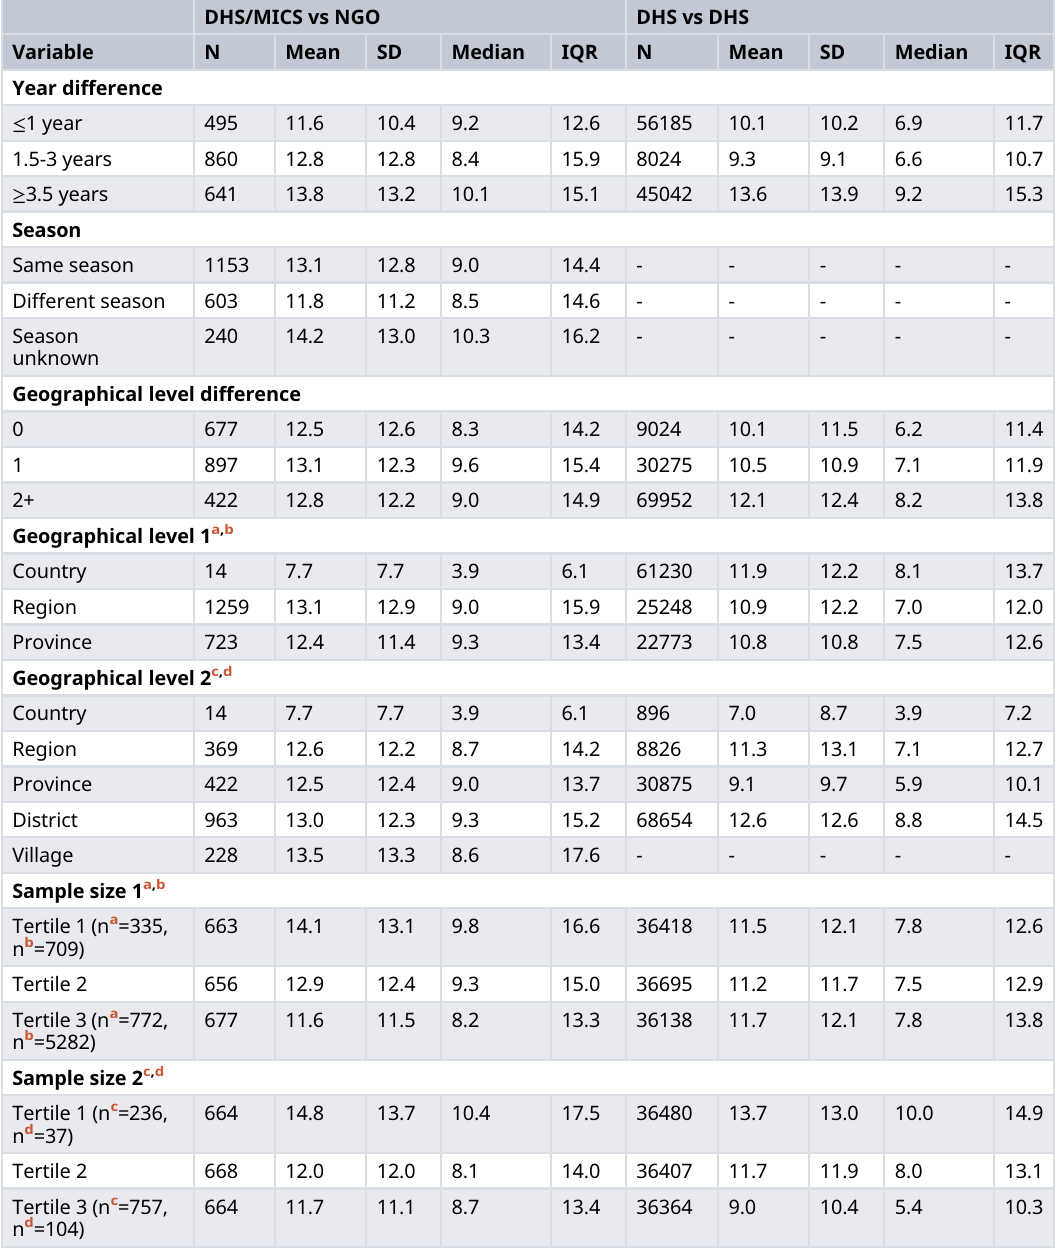
Table 7. Absolute difference of estimates by year difference, season, geographical level, and sample